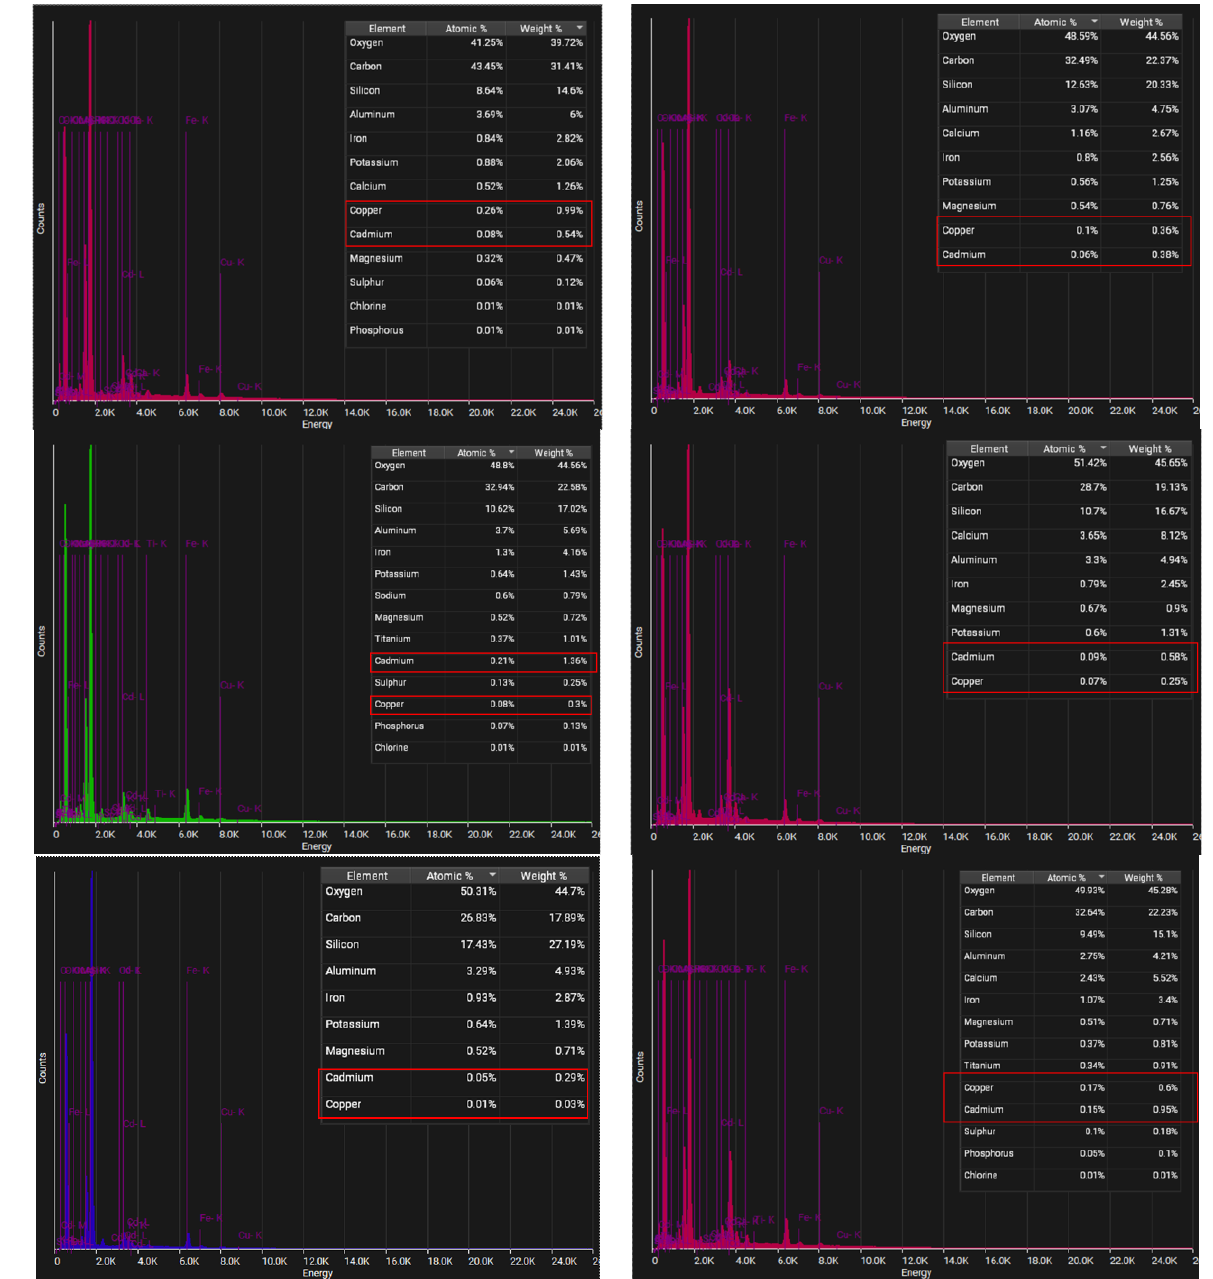
Figure 5. Elemental analysis of Romanian and Tunisian soils after the adsorption process.